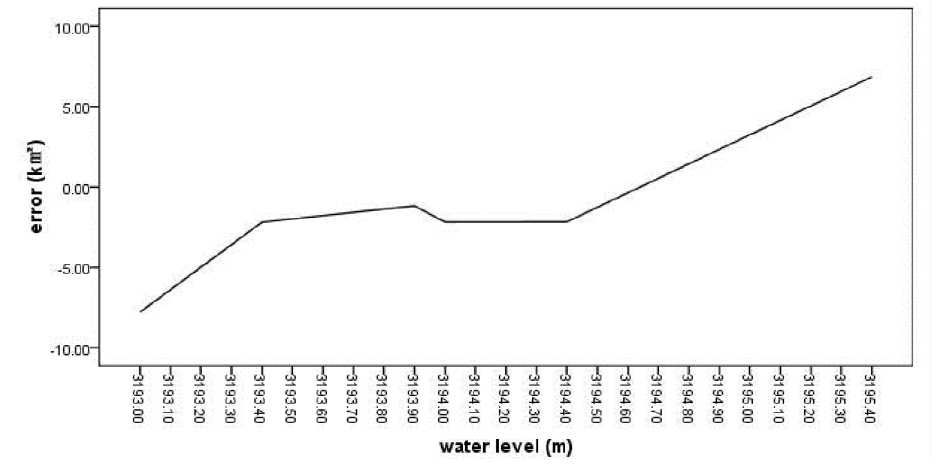
Figure 14. The error of surface areas obtained at different water levels was evaluated by calculating the difference between the surface areas estimated by the L-A equation in Figure 6 and the surface areas retrieved by the L-A curve provided by the Hydrology and Water Resources Survey Bureau of Qinghai